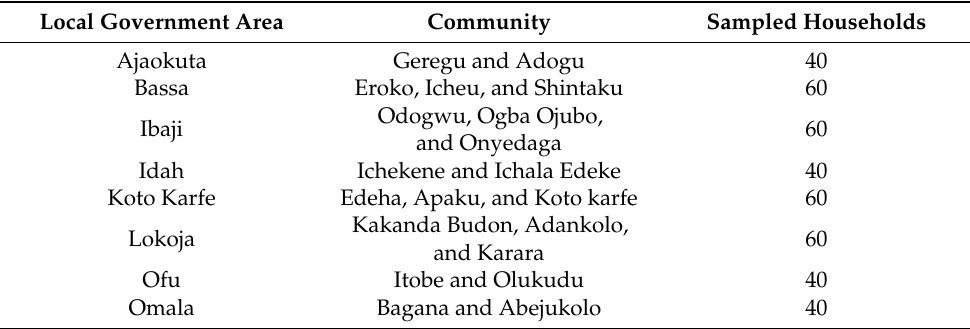
Table 1. Sampled size of households in the selected communities. Local Government Area Community Sampled